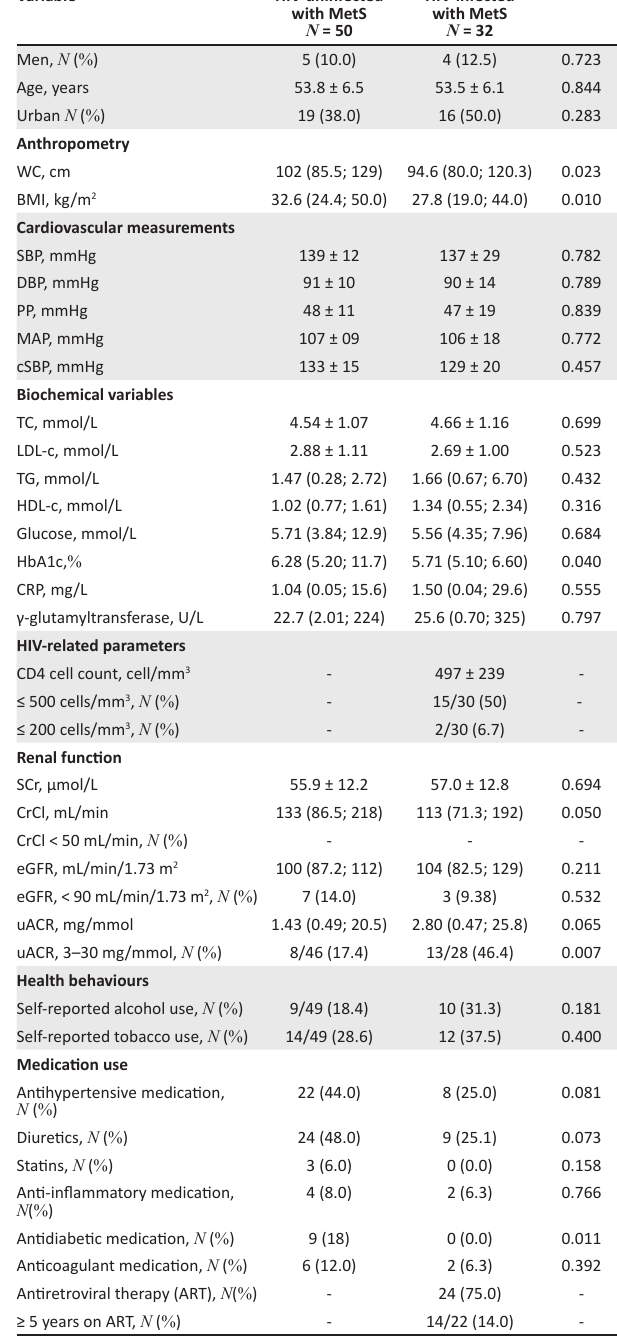
TABLE 1: Characteristics of the HIV-uninfected and HIV-infected individuals (2015). Variable